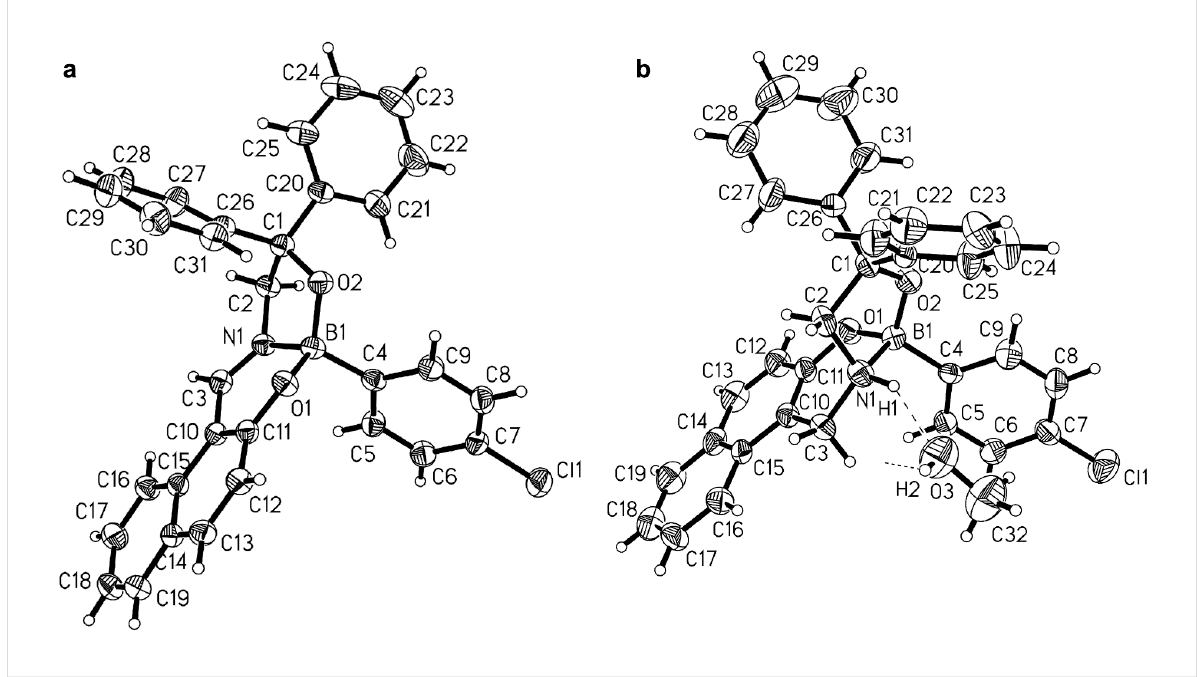
Figure 1: Solid-state structure of boronate–imine complex 8 (a) and the chosen asymmetric unit of the crystal structure of boronate–amine-complex solvate 10 ·CH 3 OH (b) showing the hydrogen bonding of the methanol molecule (right). Displacement ellipsoids are drawn at the 30% probability level, radii of hydrogen atoms are chosen arbitrarily and the hydrogen atom labels are omitted for clarity. Selected bond distances and angles are given in Table 1.